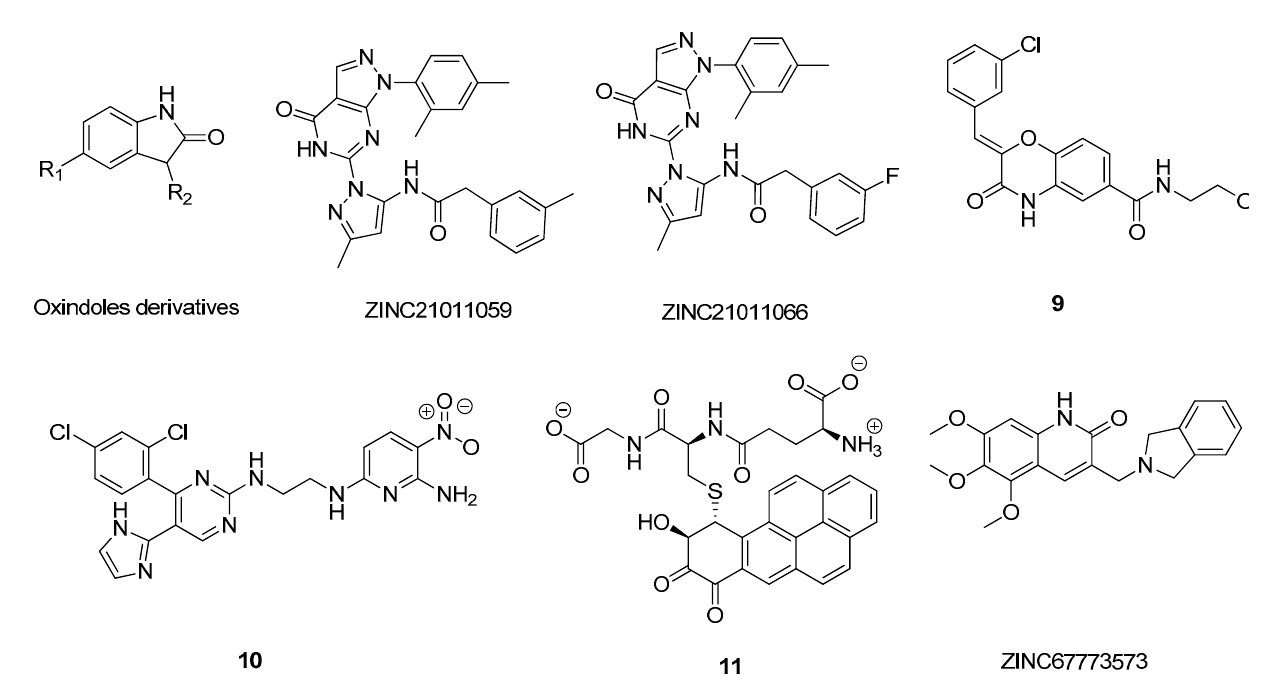
Figure 13. Structure of the studied GSK-3 inhibitors.